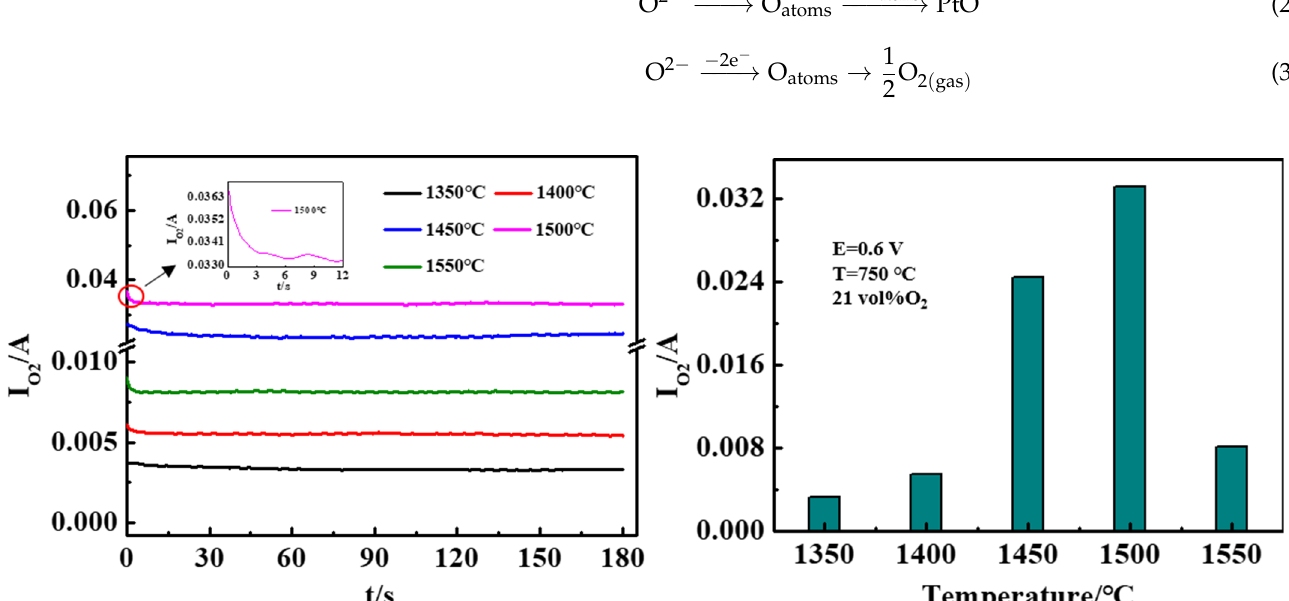
Figure 7. Chronoamperometric curves of Pt/YSZ electrodes at different sintering temperatures ( left ) current versus time; ( right ) steady current value.